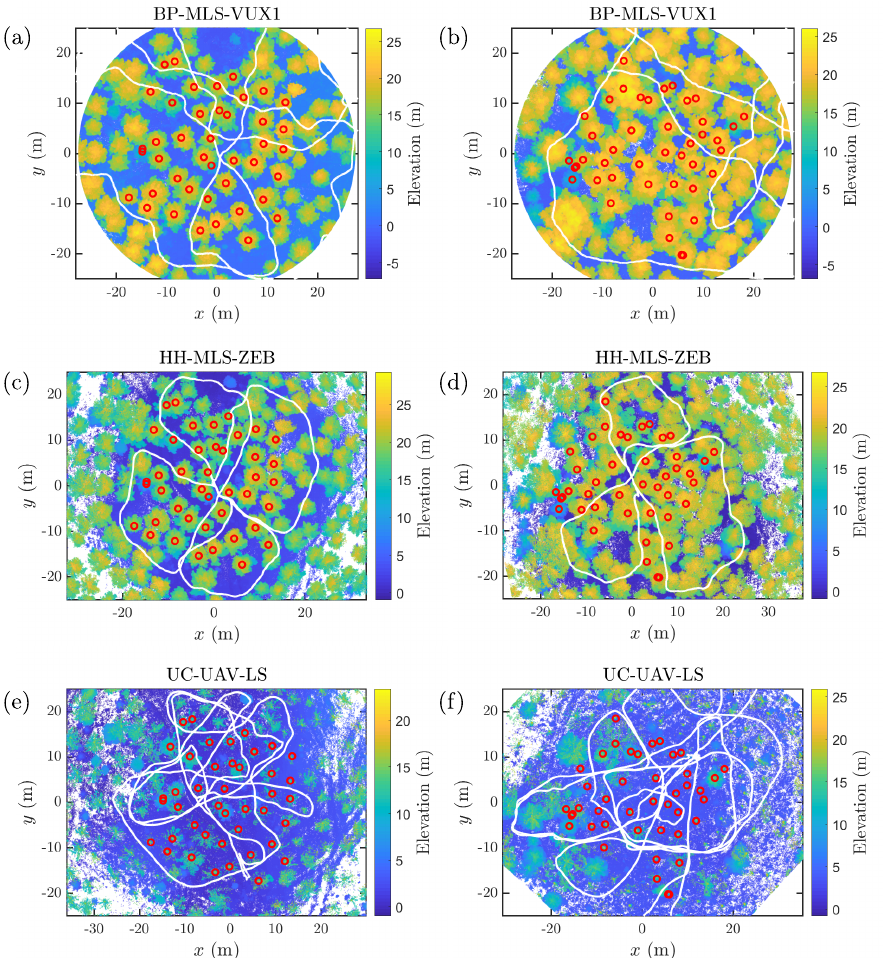
Figure 4. ( a , b ) Trajectory (white line) of the scanner for the measurements conducted with the backpack BP-MLS-VUX1 system ( a ) in the sparse plot and ( b ) in the obstructed plot. ( c , d ) Trajectory (white line) of the scanner for the measurements conducted with the handheld HH-MLS-ZEB system ( c ) in the sparse plot and ( d ) in the obstructed plot. ( e , f ) Trajectory (white line) of the scanner for the measurements conducted with the under-canopy UC-UAV-LS system ( e ) in the sparse plot and ( f ) in the obstructed plot. In all the panels, the red circles denote the positions of reference